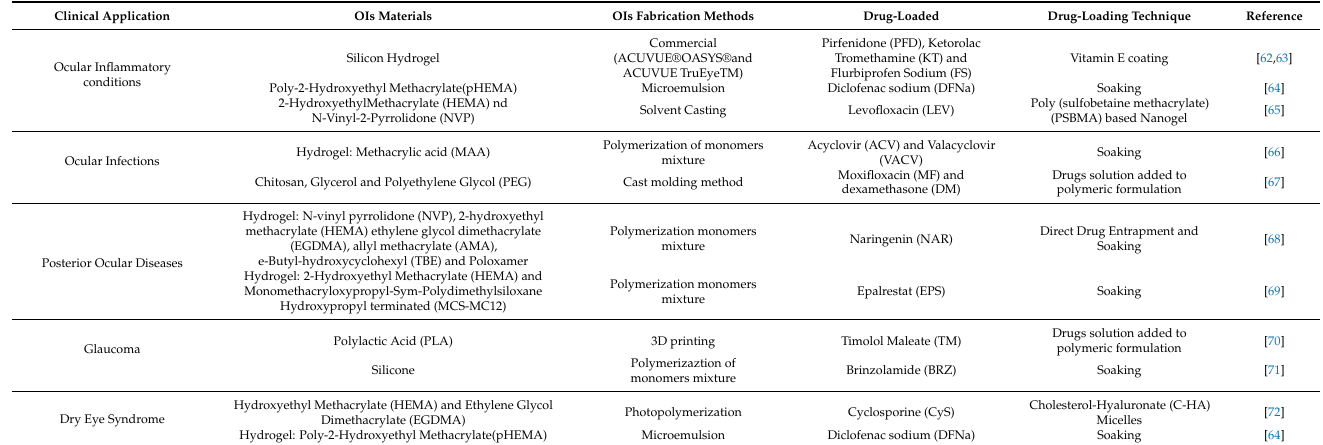
Table 2. Summary of the studies for drug-loaded